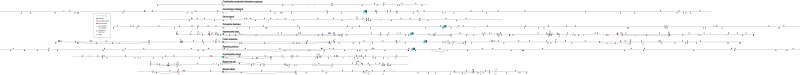
A single motif instance (14) appears conserved within some of the Hemiptera, excluding Sternorrhyncha.